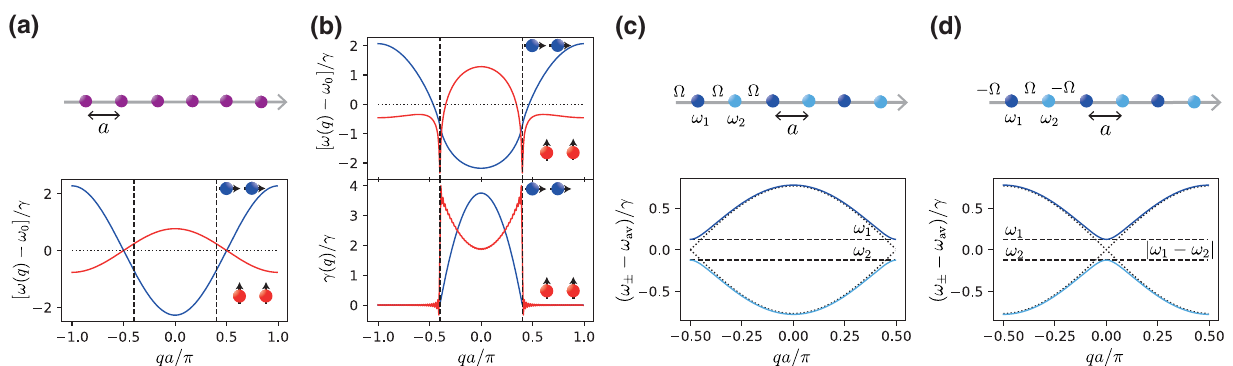
FIG. 5. (a) Energy band structure for a simplified model of a chain of nearest-neighbor-coupled identical emitters, for two different alignments of dipoles (perpendicular and parallel to the chain). (b) Top: band structure considering the exact expression of near-field coupling (cid:9) jj (cid:4) and in the presence of collective radiative decay γ jj (cid:4) . Bottom: corresponding decay rate as a function of the quasimo- mentum q . The light cone characterized by ω = c | q | , here plotted at the two-level resonance ω 0 = ck 0 is indicated by the dashed black lines. Parameters are a /λ 0 = 0.2 with N = 200 as in Ref. [3]. (c) Band structure for a chain of equidistant emitters with two different alternating species. A band gap of size | ω 1 − ω 2 | around ω av = (ω 1 + ω 2 )/ 2 is opened. (d) Additionally, when the interaction